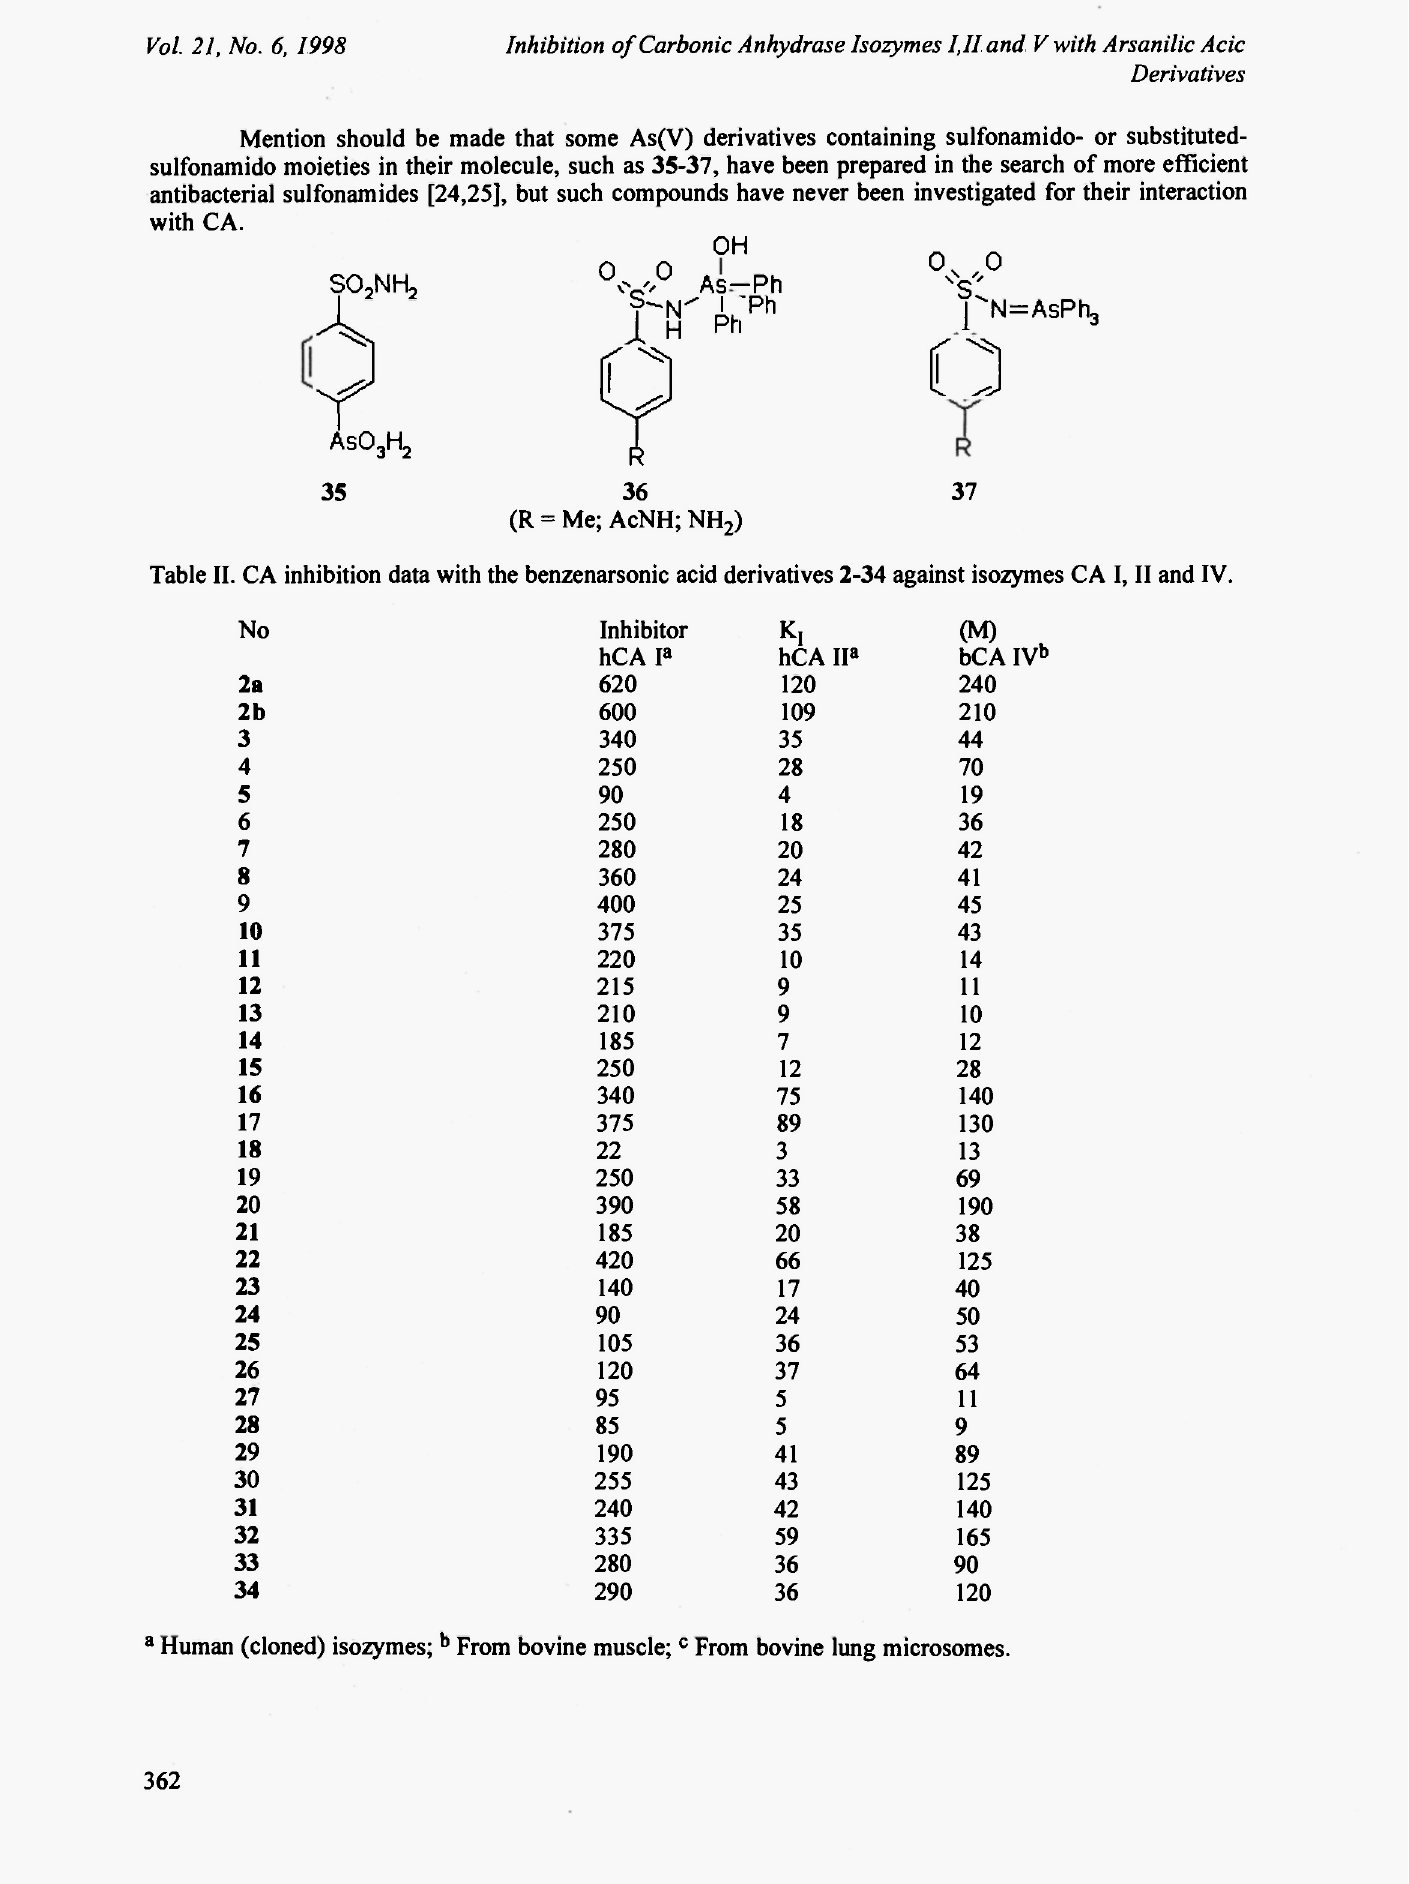
Table II. CA inhibition data with the benzenarsonic acid derivatives 2-34 against isozymes CA I, II and IV. No Inhibitor K, hCA II